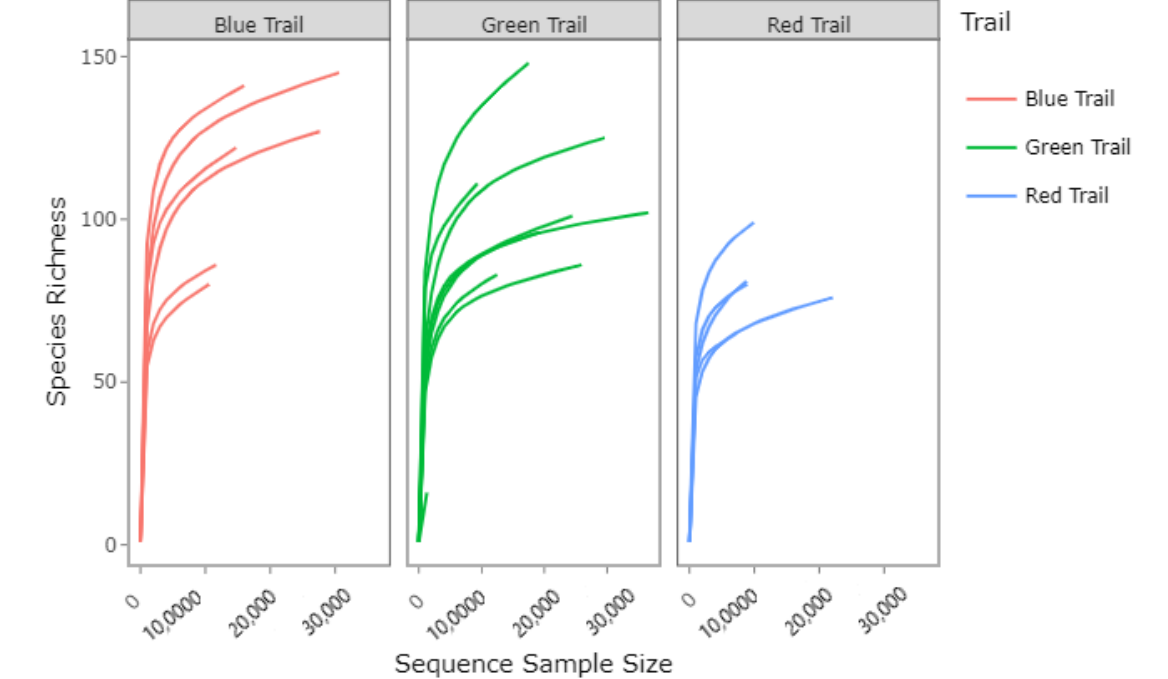
Figure 2. Fungi species richness curves for the three Trail areas of the Gold Creek Preserve.